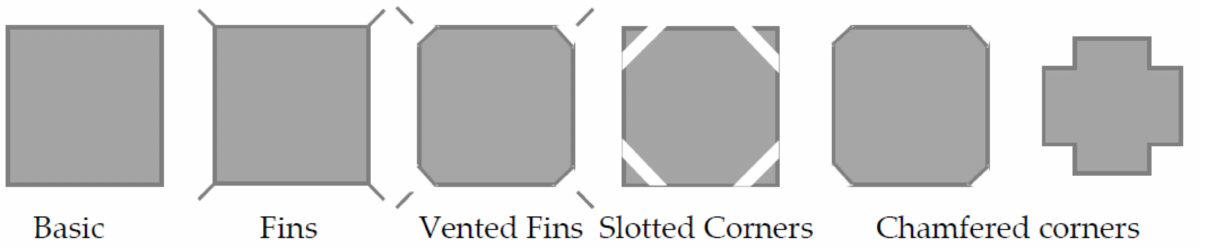
Figure 10. Examples of aerodynamic modifications to square building